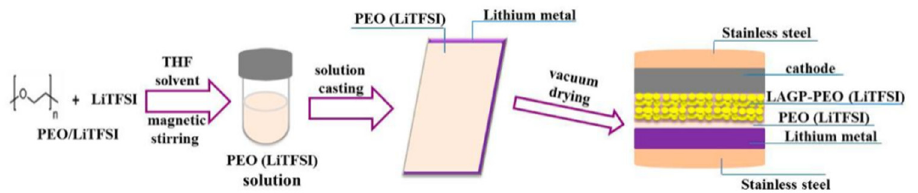
Figure 8. All-solid-state Li-PEO (LiTFSI)/LAGP-PEO (LiTFSI)/LiMFP cells. Reprinted with permis- sion from ref. [127]. Copyright 2017 American Chemical